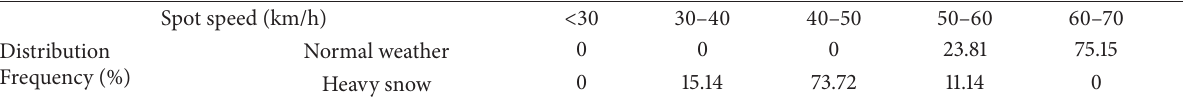
Table 3: Spot speed distribution in certain expressway section.